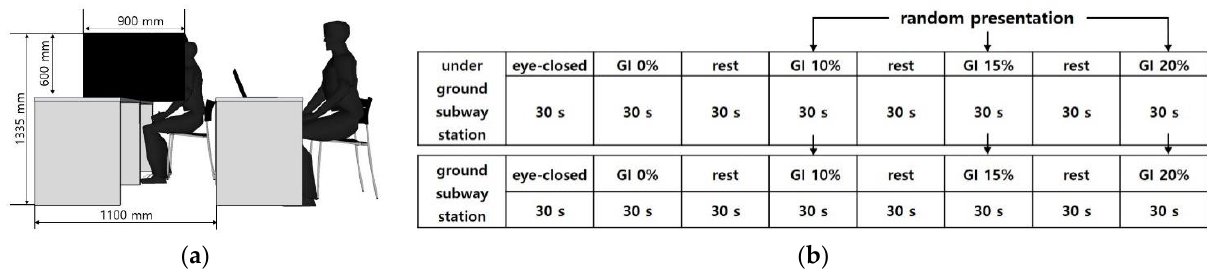
Figure 3. EEG Experimental Environment Configuration and Experimental Method: ( a ) EEG Experimental Environment Configuration; ( b ) EEG Experimental Environment Experiment Sequence Diagram.